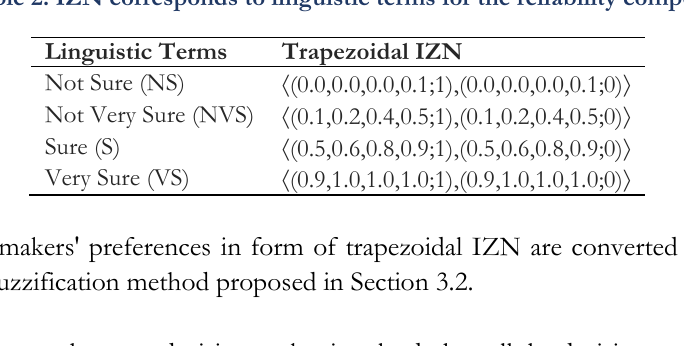
Table 2. IZN corresponds to linguistic terms for the reliability